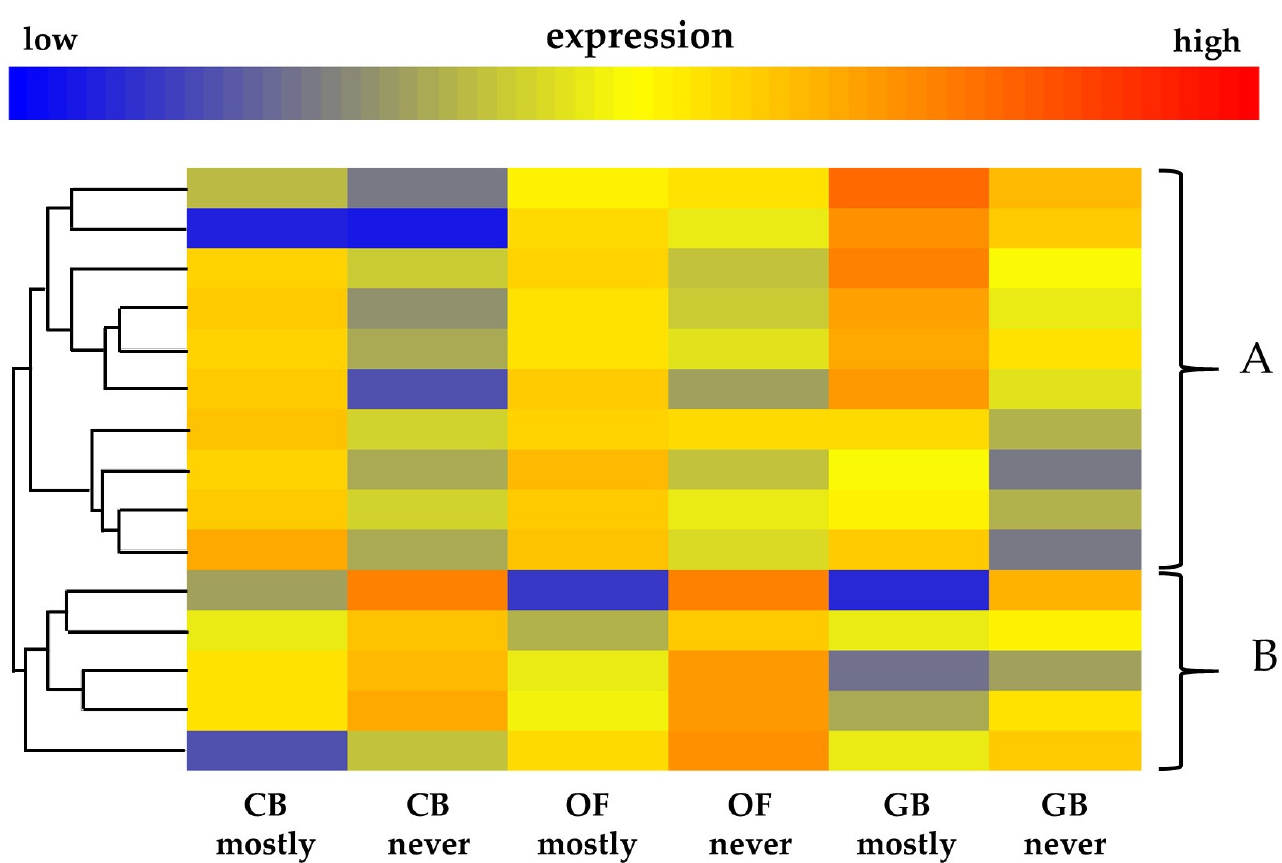
Figure 2. Tree cluster heatmaps of 15 microarray probes mapped inside the three crumbly QTLs. The 15 probes, all showing statistically significant difference for the stage*phenotype interaction effect, were selected because of their specific ontology terms (see Table 2 for details) related to flower development (3 probes), pollen (2 probes), and hormones (10 probes). In total, two clear clusters are highlighted with curled brackets at the right side of the heatmap. The top cluster contains 10 probes all upregulated in the mostly crumbly plants, is named ( A ) while the small cluster on the bottom with five probes, all downregulated in the mostly crumbly plants, is named ( B ). Mostly crumbly indicates those plants bearing mainly misshapen crumbly like fruit while those never crumbly are symptomless plants. The three different fruit development stages tested were: closed bud (CB), open flower (OF), and green berry (GB). High expression levels are indicated in red while low expression level in blue as per scale bar presented. Table 2. List of 15 microarray probes within the Glen Moy genome scaffolds located within the three crumbly QTLs on linkage group 1 and 3. The 15 probes are listed in the same order of the tree cluster heatmap of Figure 2. These probes have A. thaliana ortholog gene ontology (GO) annotation related to hormones, pollen, or flower development. cr_JHI_3– 20 indicates the crumbly QTL identified during this work on linkage group 3 while cr_JHI_1–15 and cr_JHI_3–15 indicate the original crumbly QTLs identified on linkage group 1 and 3 by Graham et al. [1]. The stage/s to which a significant difference (stage*phenotype interaction p < 0.001) between the two phenotypes tested is found, are indicated with bold lowercase letters as follows: a = only closed bud, b = open flower, c = green berry, d = closed bud and open flower, e = closed bud and green berry, f = open flower and green berry, and g = closed bud, open flower, and green berry.